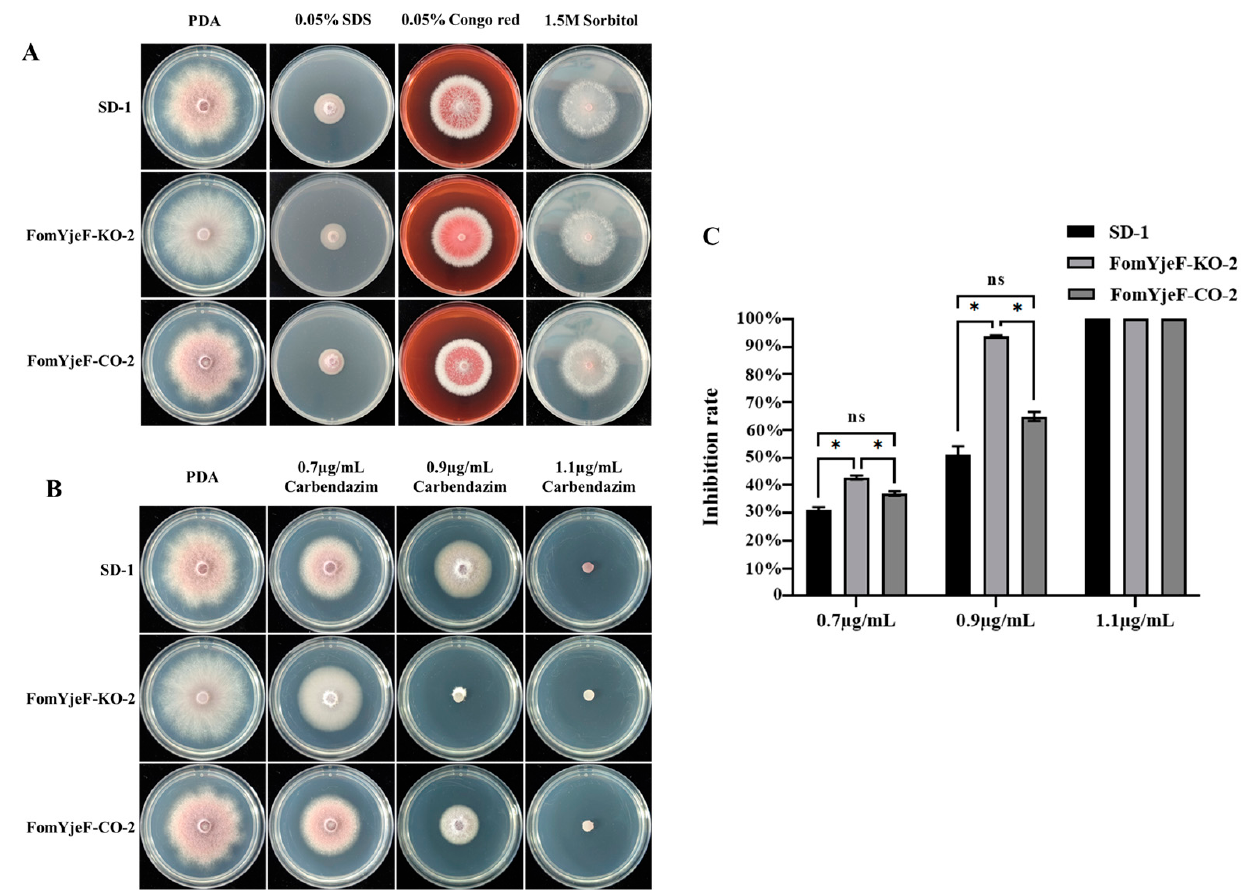
Figure 3. The abiotic stress and carbendazim response of mycelial growth in wild-type SD-1, FomYjeF deletion, and FomYjeF -complemented strains. ( A ) Colonies of SD-1, FomYjeF-KO-2, and FomYjeF-CO- 2 were cultured on a PDA medium amended with 0.05% SDS, 0.05% Congo red, and 1.5 M sorbitol. ( B ) Colonies of SD-1, FomYjeF-KO-2, and FomYjeF-CO-2 were cultured on a PDA medium amended with 0.7 µg/mL, 0.9 µg/mL, and 1.1 µg/mL carbendazim. ( C ) The inhibition rate of mycelial growth of carbendazim. All Petri dishes were incubated at 28 °C for 5 days. * over the histogram indicates stand- ard error of the mean (SEM) at p < 0.05 (two-way ANOVA test). ns indicates no significant difference. Error bars represent the SEM of three biological replicates with three technical replicates.